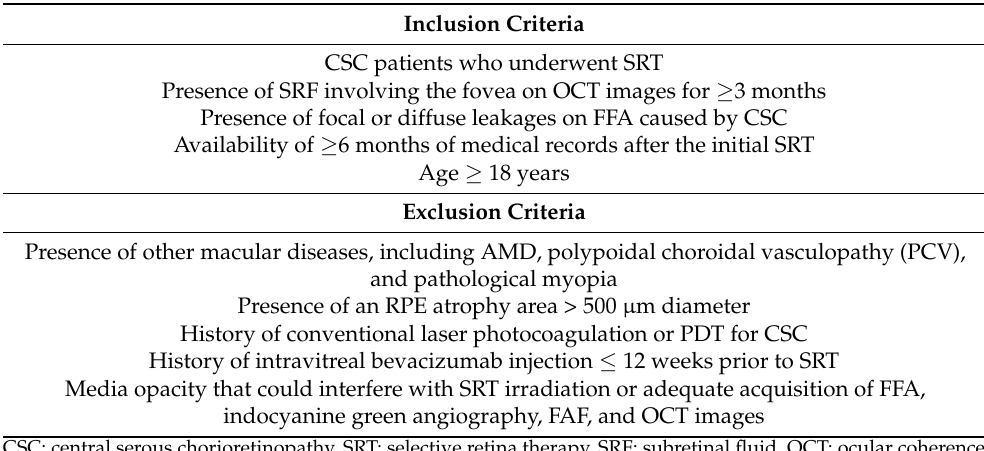
Table 1. Inclusion and exclusion